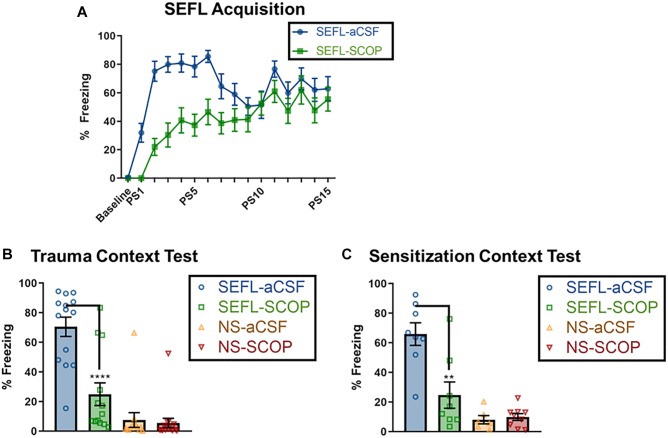
Scopolamine disrupts trauma memory formation and future sensitization. (A) SEFL Acquisition, where baseline represents the average freezing for the 3 min baseline, and “PS” designates post-shock freezing, as measured for 30 s beginning 30 s after the end of a shock. Non-shocked (NS) rats received a context exposure of the same length, but without any shocks; none exhibited freezing (data not shown). Both scopolamine and aCSF groups demonstrate post-shock freezing, though scopolamine rats have a slower rate of learning, as measured by lower levels of freezing toward the beginning of the session, but no difference by the end of the session (n = 15 per group). Data for the following two graphs are averaged across an 8 min test. (B) Stress Context Test. While SEFL-aCSF rats have very high levels of freezing, scopolamine attenuated the contextual freezing during the trauma test (n = 13 or more per group). (C) Sensitization Test. Rats that received one shock but no prior trauma (NS) show low freezing to the sensitization context. SEFL-aCSF rats show profoundly elevated freezing to the single shock; this freezing is attenuated by scopolamine administration prior to SEFL (SEFL-SCOP) (n = 6 or more per group). All individual data shown, error bars indicate SEM.